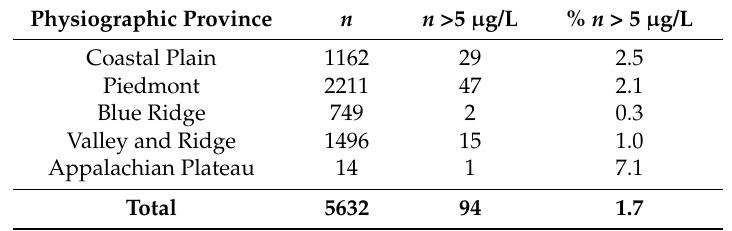
Table 4. Total number of samples, number of samples that exceed 5 µ g/L As, and percent of samples that exceed 5 µ g/L from the combined dataset, separated by physiographic province in Virginia.